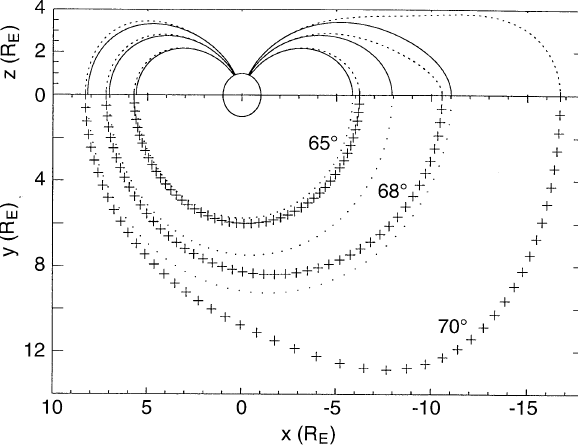
Fig. 1. Auroral field lines (65 ° , 68 ° , and 70 ° MLAT) of the Mead- Fairfield magnetosphere model. In the noon-midnight plane ( top ) quiet state is represented by continuous lines and the disturbed state by dotted lines . The field-line footprints in the equatorial plane ( bottom ) are represented by dots for quiet state and by crosses for the disturbed magnetosphere